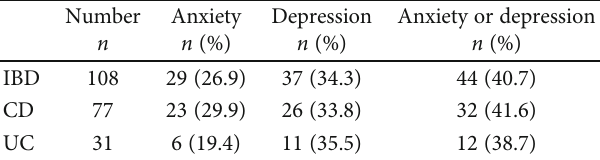
Table 4: Detection rate of anxiety or depression in IBD